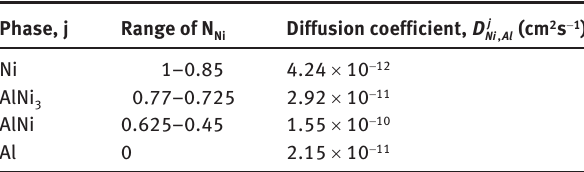
Table 3: Thermodynamic and kinetic data used to simulate the reactions in the Ni-Al system at 1323 K.